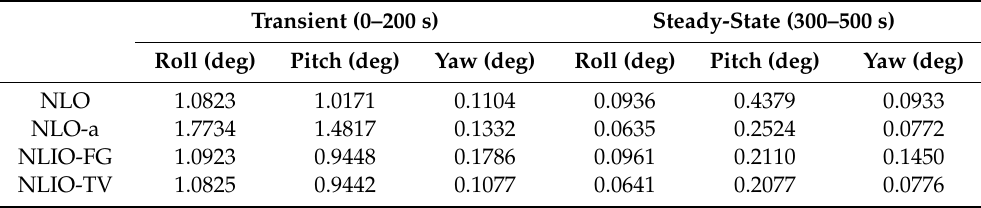
Table 2. RMSEs of attitude for all the nonlinear observers in Case 1.